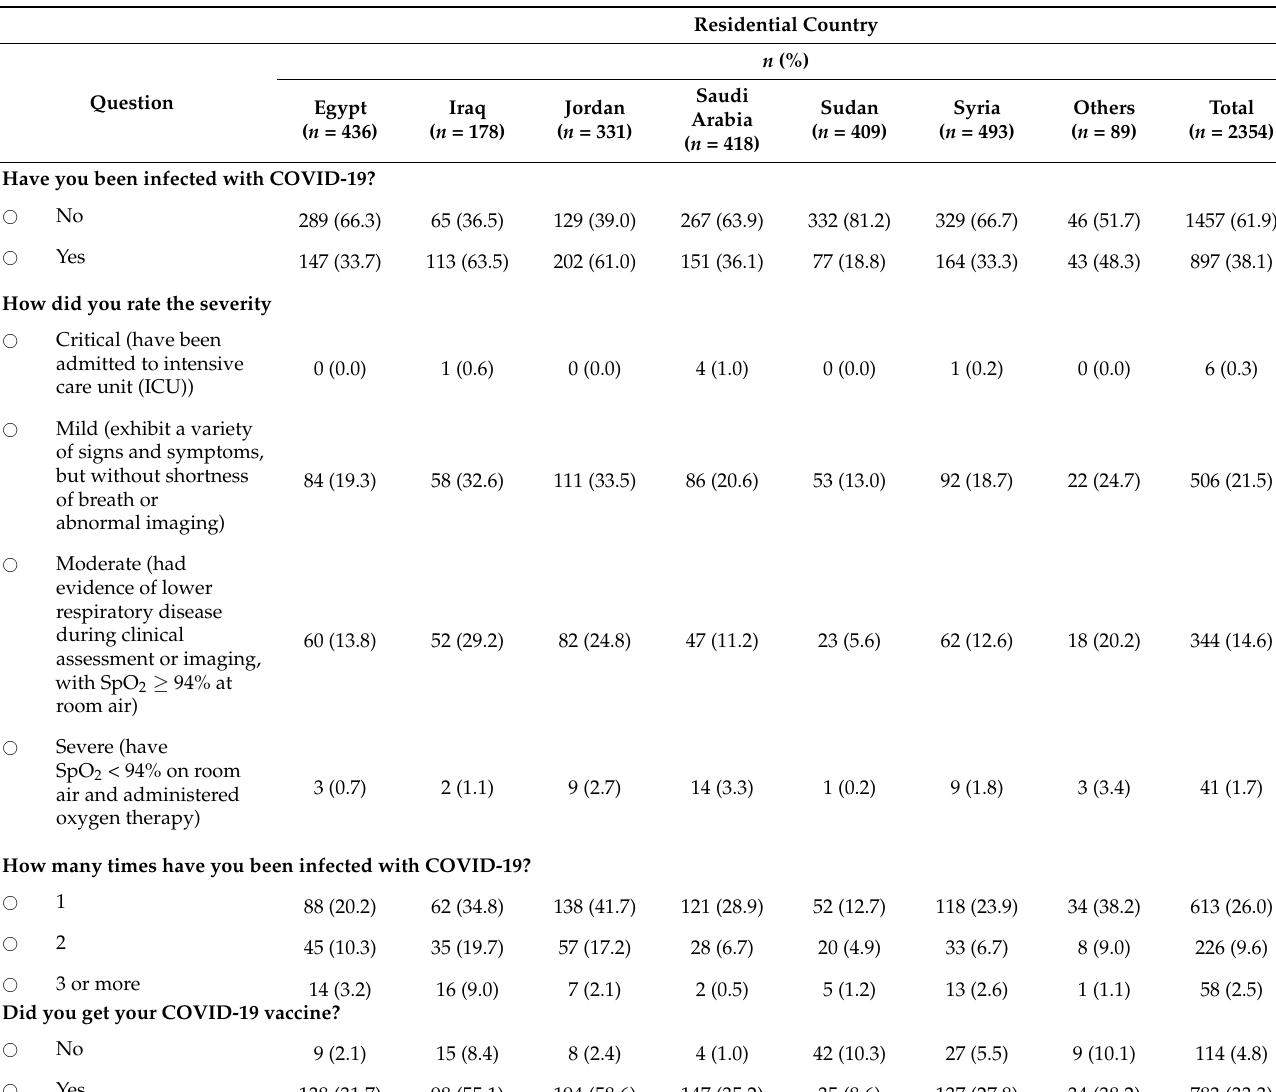
Table 2. Participants reported history of COVID-19